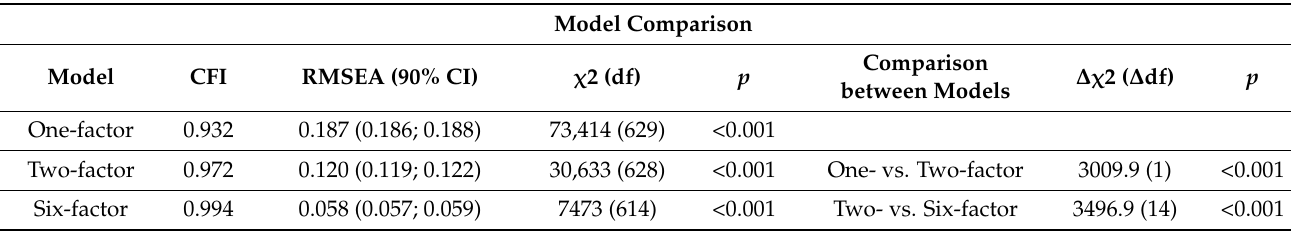
Table 5. Results of confirmatory factor analyses of the QOLIBRI in general